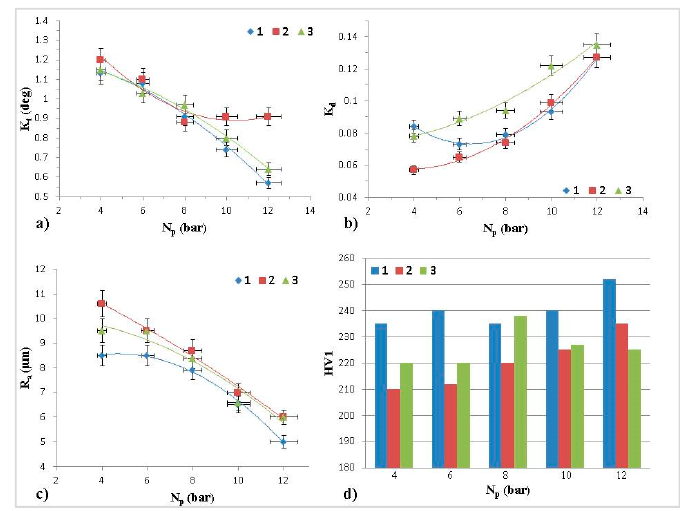
Figure 4. Cut quality vs. nitrogen pressure and focus position: ( a ) Kerf taper, ( b ) Kerf deviation, ( c ) average roughness, and ( d ) microhardness. 1—material top, 2—material bottom, 3—0.5 mm in front of material. Metals 2019 , 9 , 1147 14 of 20